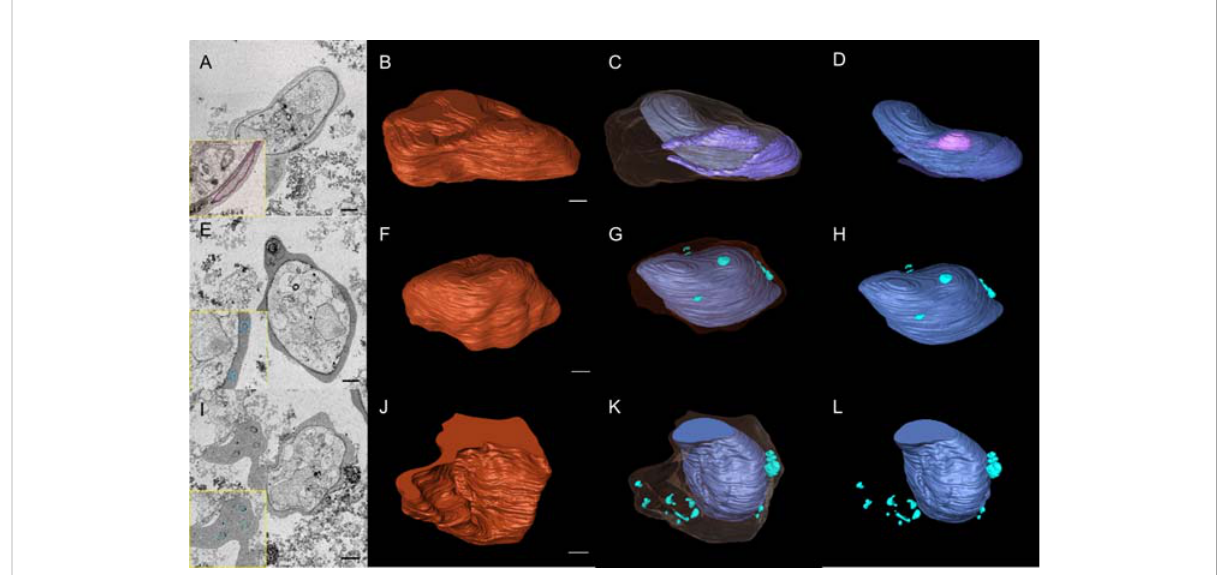
FIGURE 3 SBF-SEM images revealed complex intracellular membrane organizations in gametocytes. (A, E, I) Selected sections of SBF-SEM images with 50 nm intervals. Traces of exo-membranes are shown in insets. (B, F, J) 3D images of gametocytes reconstructed from SBF-SEM sections. (C, G, K) different size and shape of exo-membranes. The erythrocyte membranes are shown as translucent layer. (D) Structure of intracellular parasite and exo-membranes (no erythrocyte membrane is shown), showing that one large membrane includes the smaller membrane (pink). (H, L) single-layered, exo-membranes including small membranous objects, globular, spindly, and conjunct membranes exist in cytosol (green). Scale bar = 1